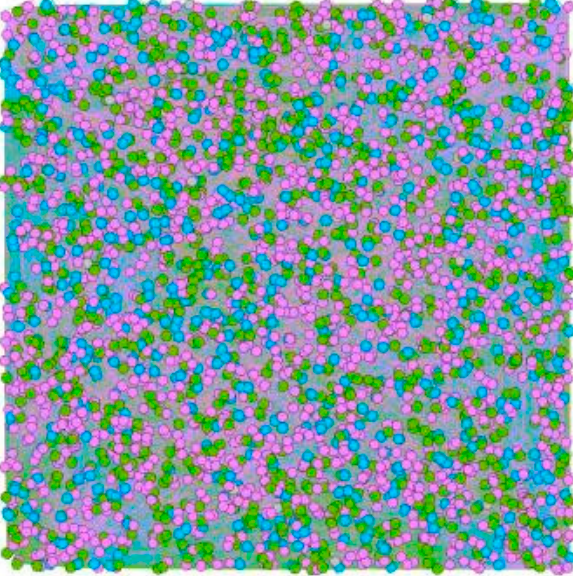
Figure 3. Default network visualization after import into Gephi (14,788 hashtags and 363,525 edges). Source: Own processing.